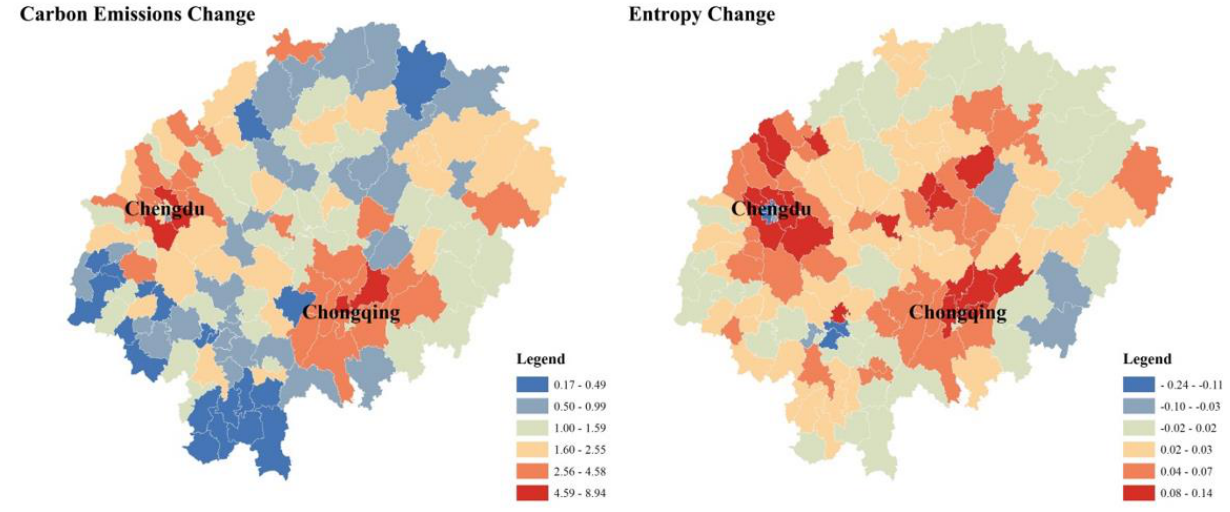
Figure 6. The 2000 − 2017 carbon emissions change and 2000 − 2018 entropy change (Natural Breaks, Jenks).